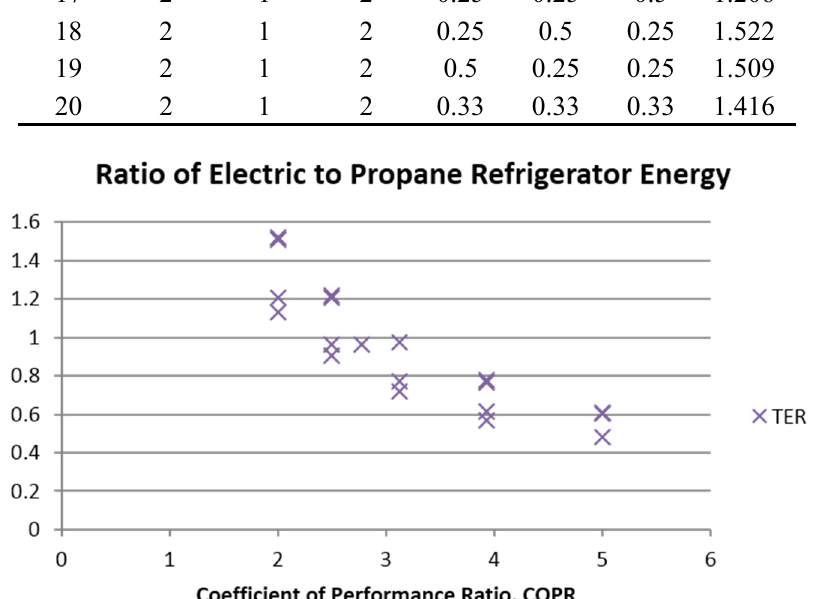
Figure 6. Ratio of electric refrigerator energy usage to propane refrigerator energy usage as a function of the Coefficient of Performance Ratio,